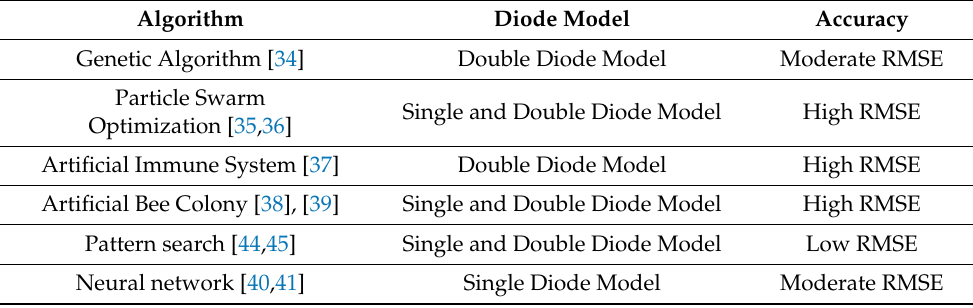
Table 2. Parameter identification using conventional and intelligent